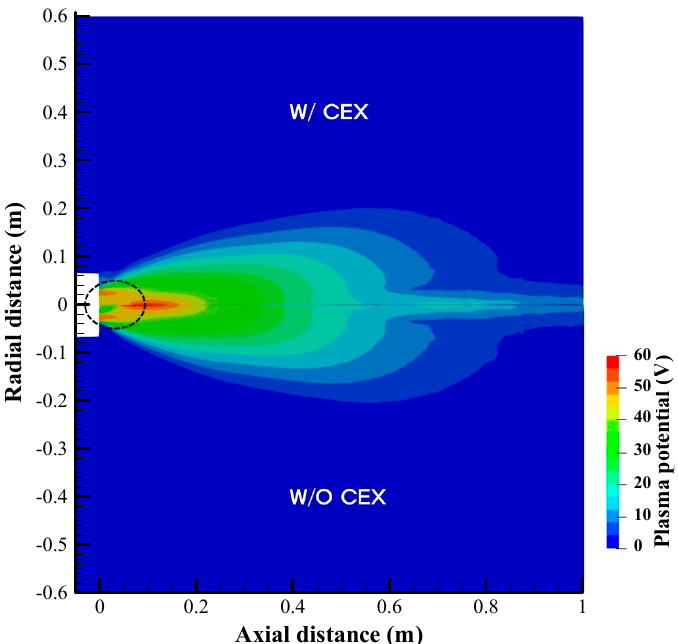
Figure 15. Contours of the plasma potential (top: with CEX, bottom: without CEX).